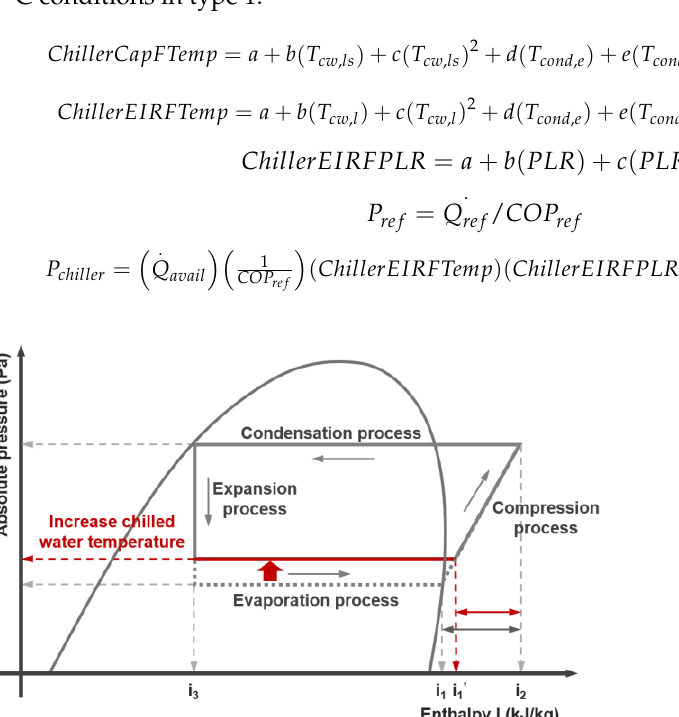
Figure 4. Annual internal load and type 1 energy consumption of the computer room. ( a ) Internal load of computer room, ( b ) type 1 energy consumption.